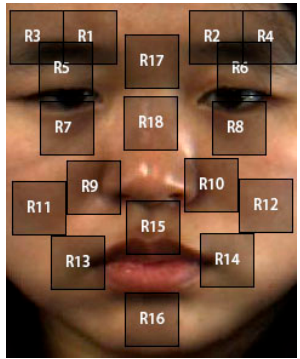
Figure 4. Position of facial active patches.